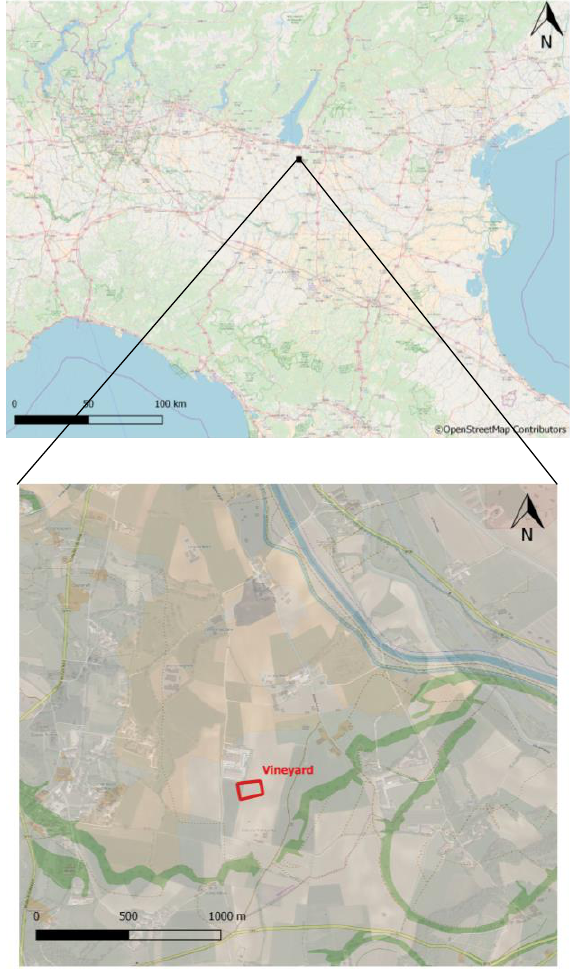
Figure 1. The Monzambano vineyard location A total of 26 black and white (30 cm x 30 cm) and black and yellow panels (50 cm x 50 cm) were placed on the ground and surveyed with a Topcon HiPer SR GNSS receiver (used in Real- Time Kinematic (RTK) mode) in order to obtain the coordinates of the GCPs and Check Points (CPs), which is fundamental to ensure a high geometric accuracy in the generation of the photogrammetric products. Moreover, the coordinates of 15 additional points were acquired with GNSS, in order to generate an independent DTM, through Kriging interpolation, to be considered as reference surface. In Fig. 2, the points used as GCPs represented in red, while all points used for the generation of the reference DTM are shown in yellow. Among these, triangles represent GNSS points employed only for Kriging interpolation, instead squares are points used also as CPs in the photogrammetric